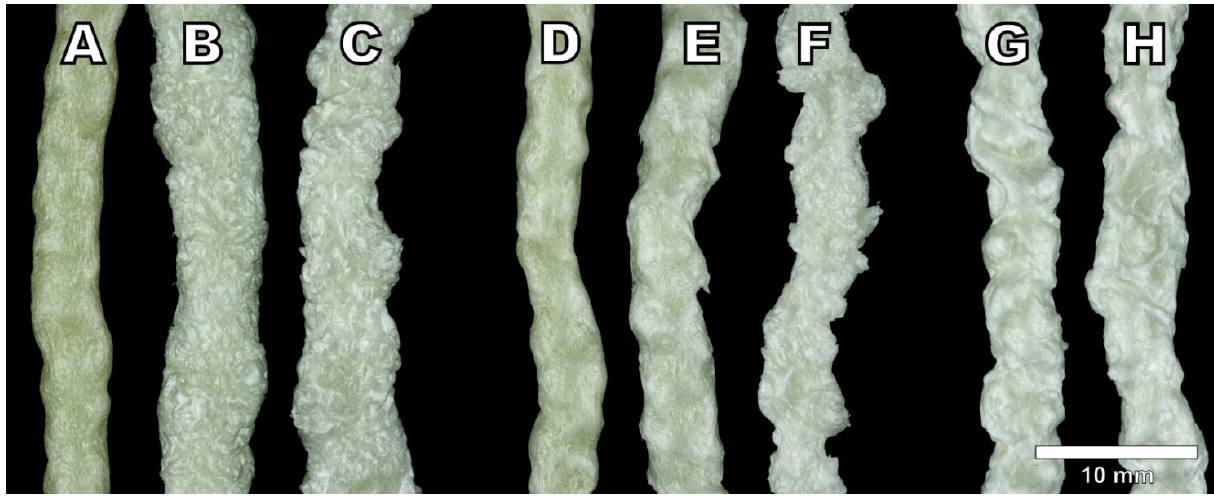
Figure 2. Side profiles of produced cellulose palmitate foams: ( A ) IB-1, ( B ) IB-3, ( C ) IB-5, ( D ) CO 2 -0.5, ( E ) CO 2 -1, ( F ) CO 2 -3, ( G ) N 2 -0,5, and ( H ) N 2 -1. The scale is